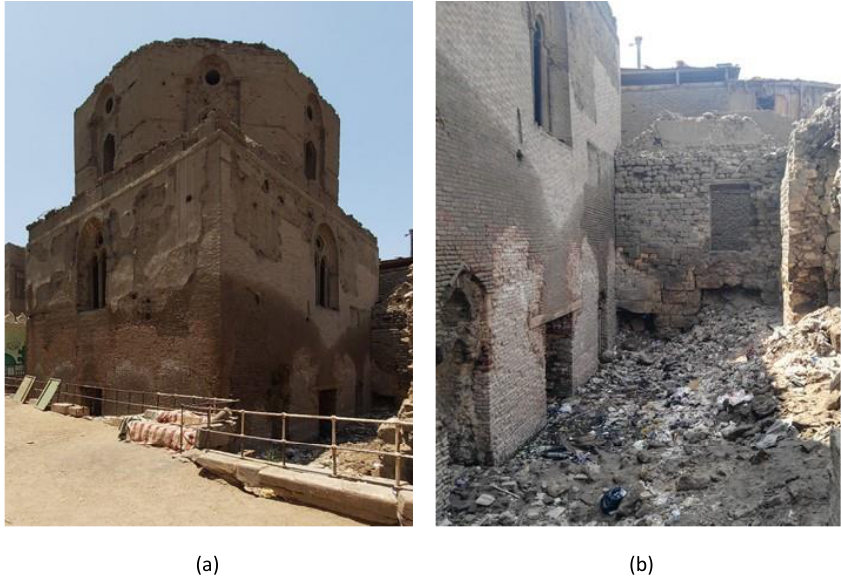
Figure 2. ( a ) The dome of Fatima Khatun (looking south). ( b ) Remains of the deteriorated school attached to the structure (looking south-west).